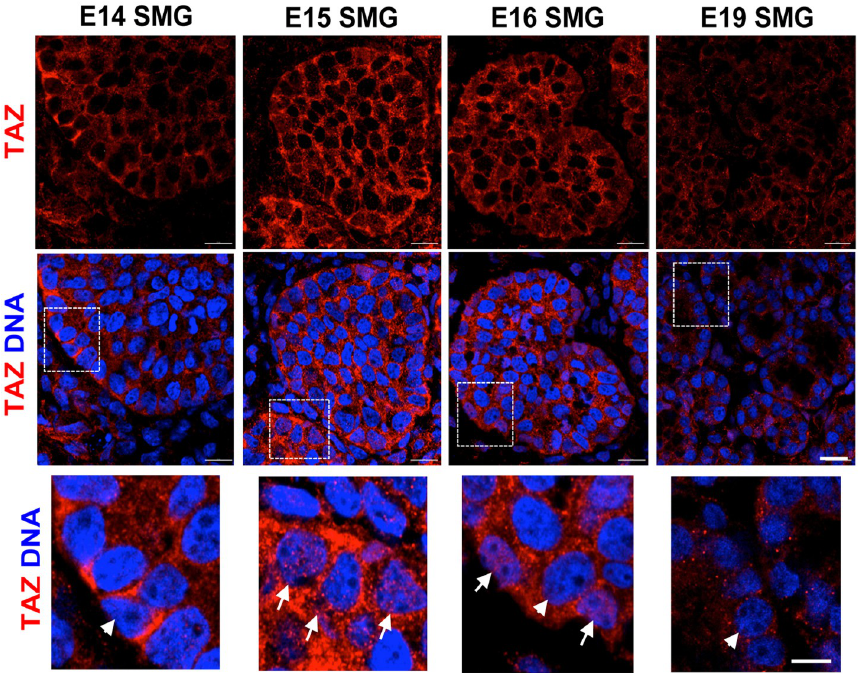
Fig 5. Expression of TAZ during SMG morphogenesis. Representative confocal images of embryonic SMGs from E14 through E19 immunostained for TAZ and DNA. Images are a single Z-slice acquired at 63X representative of four SMGs. Scale bar, 10 μ m. Insets represent a magnified view of TAZ and DNA around the basal edge of each pro-acinus. Scale bar, 5 μ m. White arrows emphasize the co-localization of TAZ and the nuclear marker DRAQ5. White arrowheads emphasize nuclei showing no TAZ